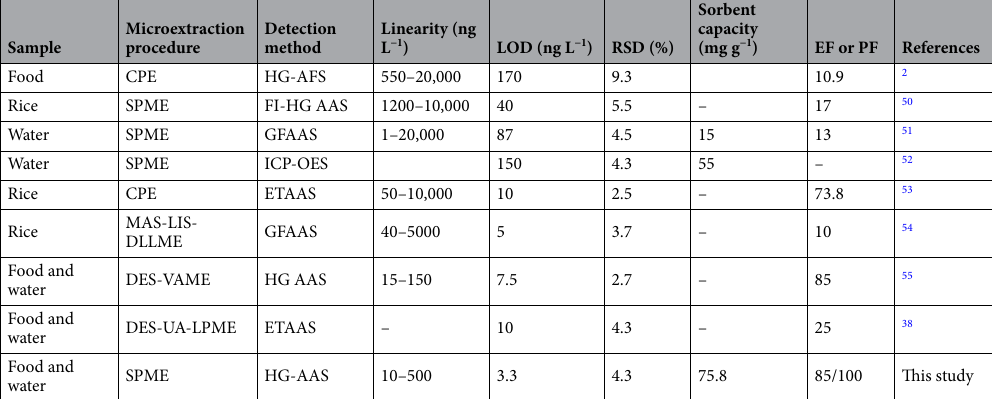
Table 9. Comparison of the proposed method with other methods applied for preconcentration and determination of inorganic arsenic. SPME solid phase microextraction, FI-HG AAS Flow injection-hydride